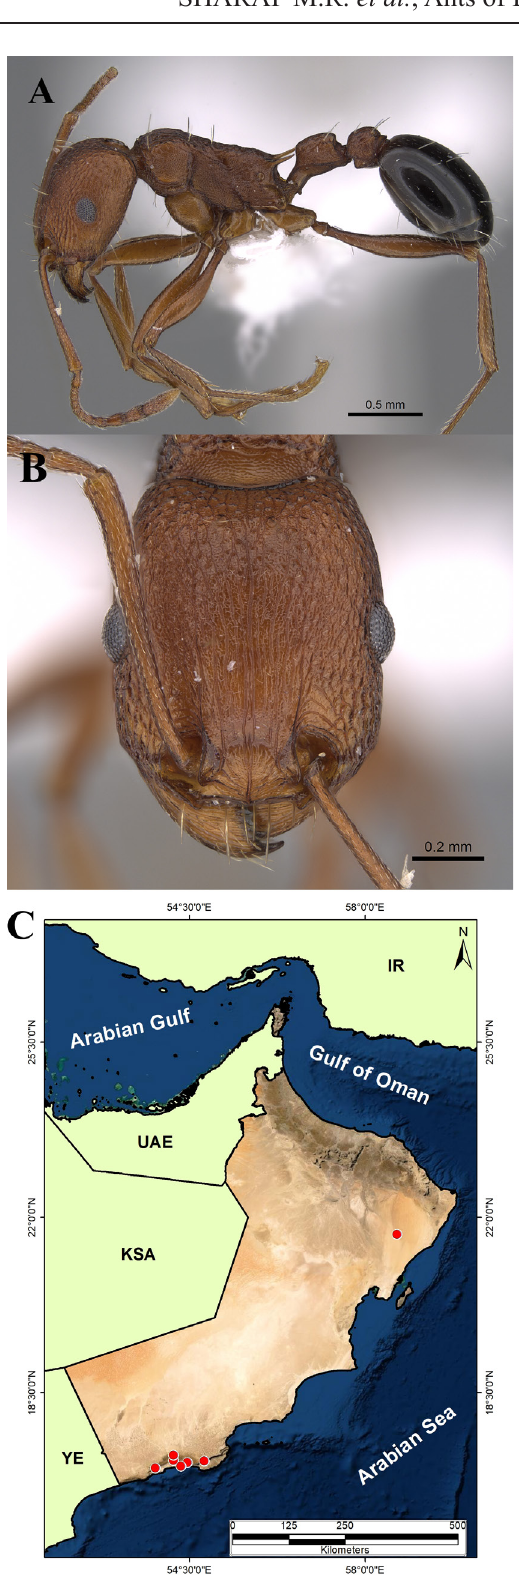
Fig. 50. Tetramorium sericeiventre Emery, 1877. worker (CASENT0922884, AntWeb.org (Michele Esposito)). A . Body in profile. B . Head in full-face view. C . Distribution